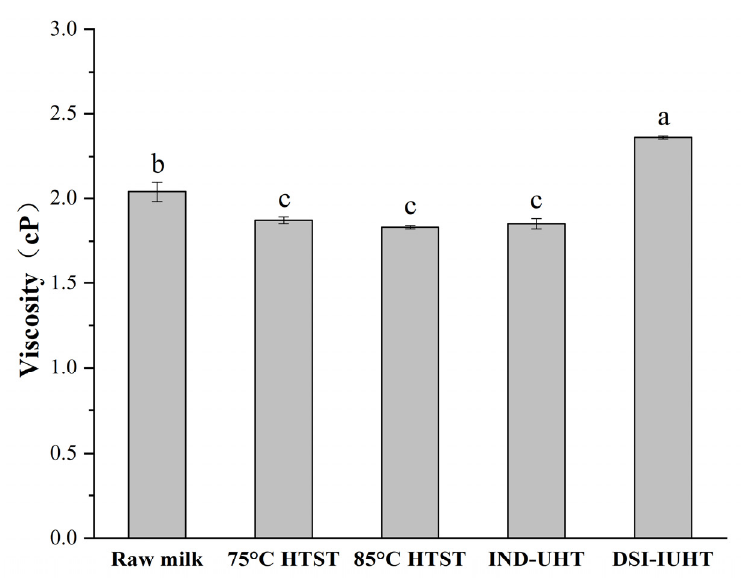
Figure 4. Viscosity of the milk samples at constant shear rate levels. The different letters of viscosity indicate significant differences ( p < 0.05).